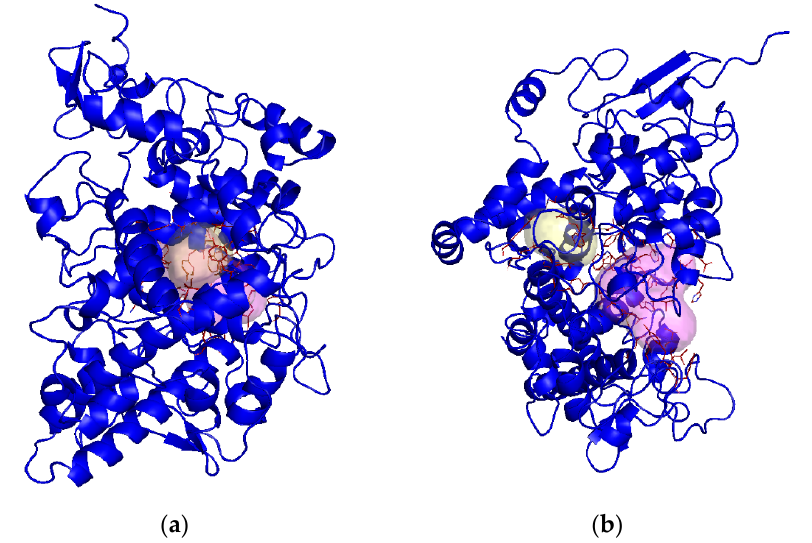
Figure 1. h COX-1 binding cavities calculated with the FLAP software: ( a ) front view and ( b ) side view Substrate-binding site (P1) is represented as a yellow surface. Heme catalytic site (P3) is represented as magenta surface. Table 3. Scores obtained for the SBVS of the new inhibitors in h COX-1 crystal structure (PDB ID: 6Y3C) performed with the FLAP